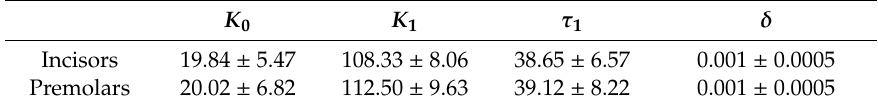
Table 3. Fitting parameters of the one-exponential function for temperature drop during polishing without water cooling, showing the average for all tested samples (n = 32).